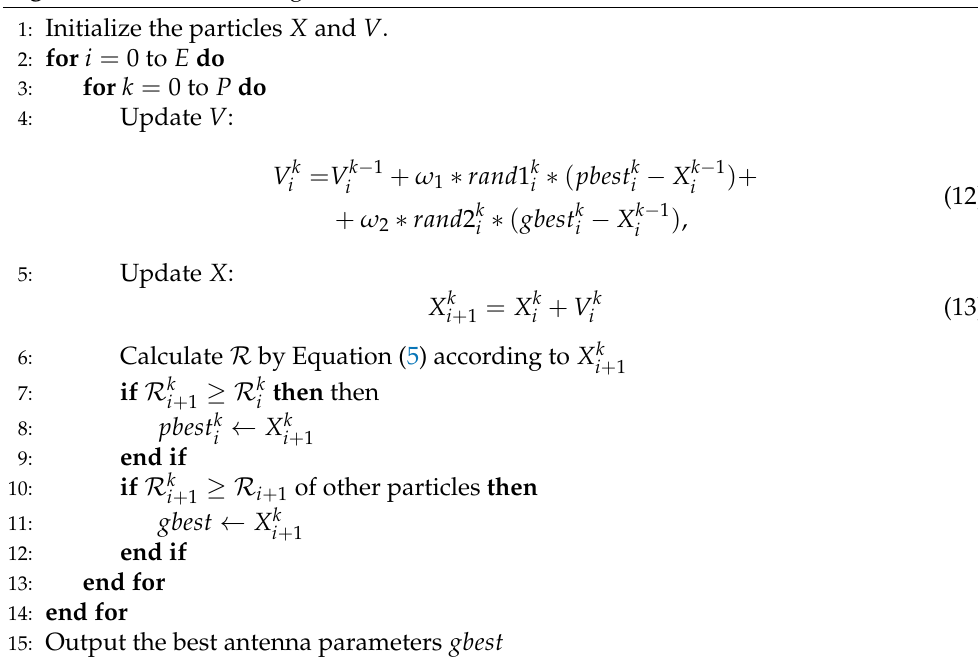
Algorithm 3 PSO based algorithm for HAPS antenna control.